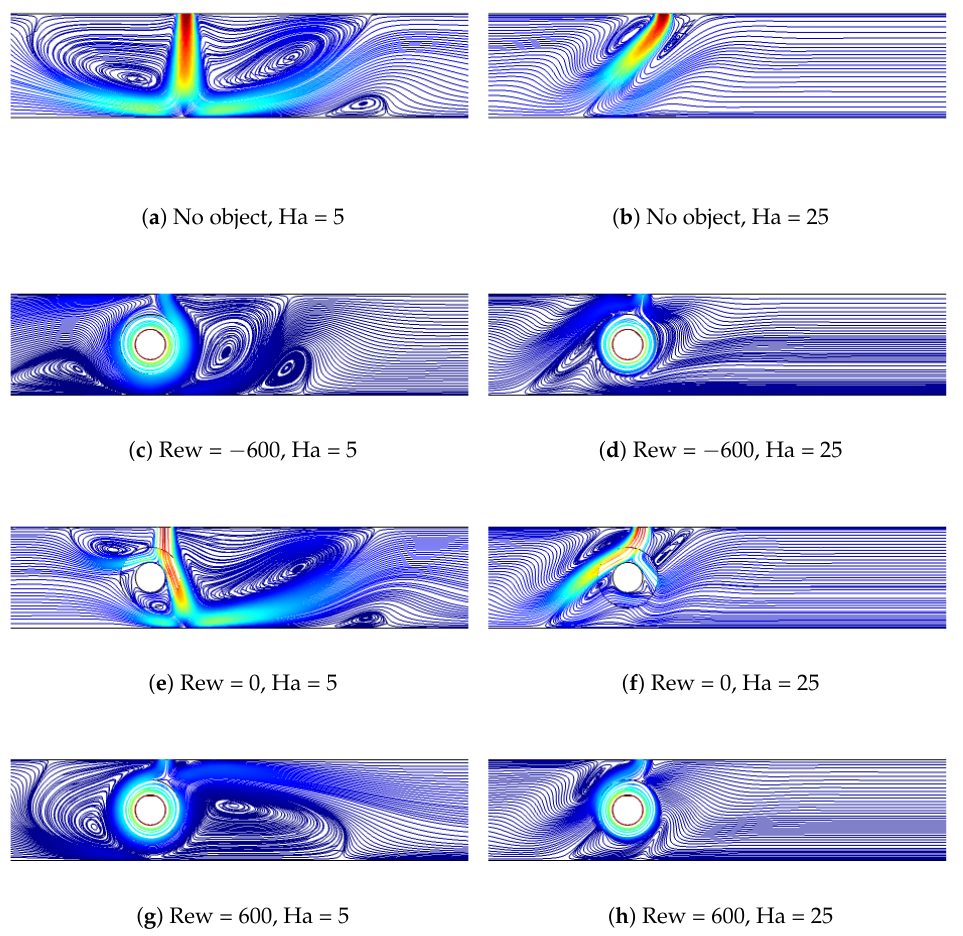
Figure 5. Effects of Rew on the streamline variations at two MaF strength levels ( c – h ) and configura- tion with no-object case ( a , b ) (Da = 5 × 10 − 2 ,Mx = − 1,AR =